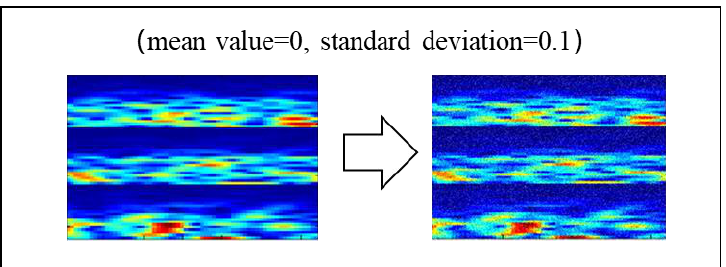
Figure 5. Data augmentation using noise addition.